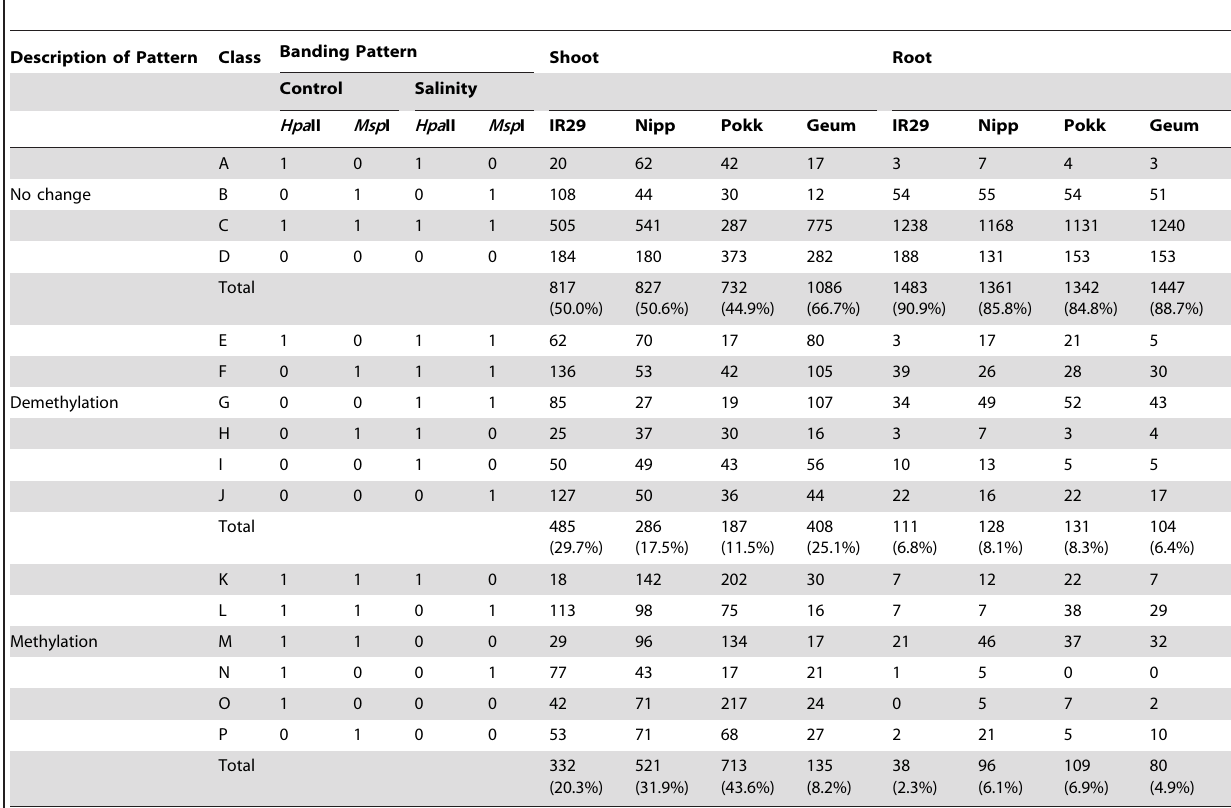
Table 2. Analysis of DNA methylation patterns under salinity stress with respect to control condition in the shoot and root of seedlings of rice varieties, IR29, Nipponbare (Nipp), Pokkali (Pokk), and Geumgangbyeo (Geum).